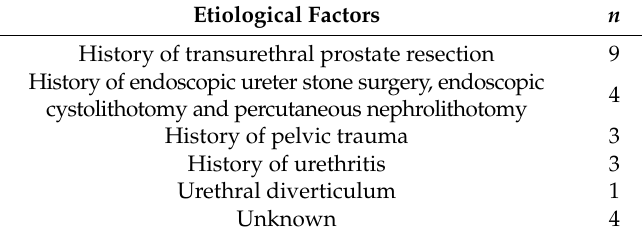
Table 2. Etiological factors predicted in urethral stone